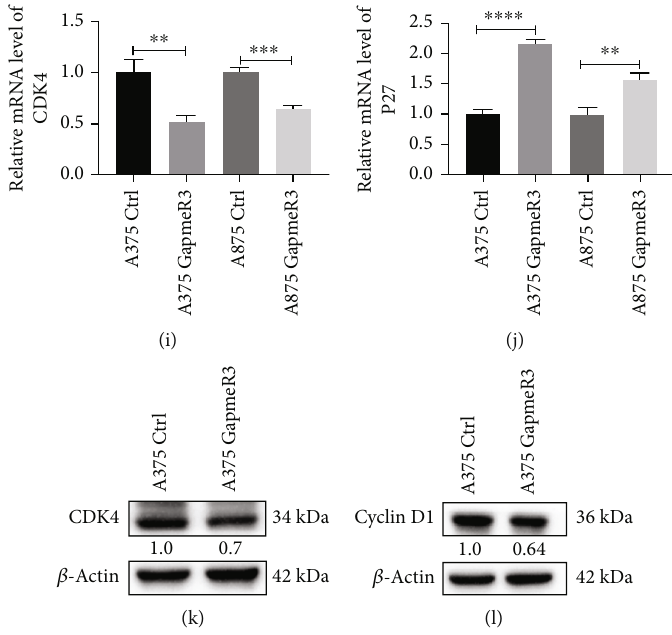
Figure 2: SAMMSON silencing inhibits melanoma cell proliferation in vitro . (a) The knockdown e ffi ciency of the ASO-mediated suppression of SAMMSON in A375 cells was detected by RT-qPCR. (b, c) Cell growth curves of SAMMSON knockdown and control melanoma cells were plotted using MTT assays. The horizontal coordinate represents the time of cell culture, and the ordinate represents the absorbance value of the cell at the wavelength of 490 nm. (d, e) Evaluation of the proliferative capacity of SAMMSON-silenced and control melanoma cells using the colony formation assay. (f – j) RT-qPCR analysis of the relative mRNA expression of caspase 3, Bcl-2, CDK2, CDK4, and P27 in SAMMSON-silenced and control melanoma cells. (k, l) Western blotting analysis of the protein expression of CDK4 and cyclin D1 in SAMMSON-silenced and control melanoma cells. ∗ p < 0 : 05 , ∗∗ p < 0 : 01 , ∗∗∗ p < 0 : 001 , and ∗∗∗∗ p < 0 : 0001 vs. control